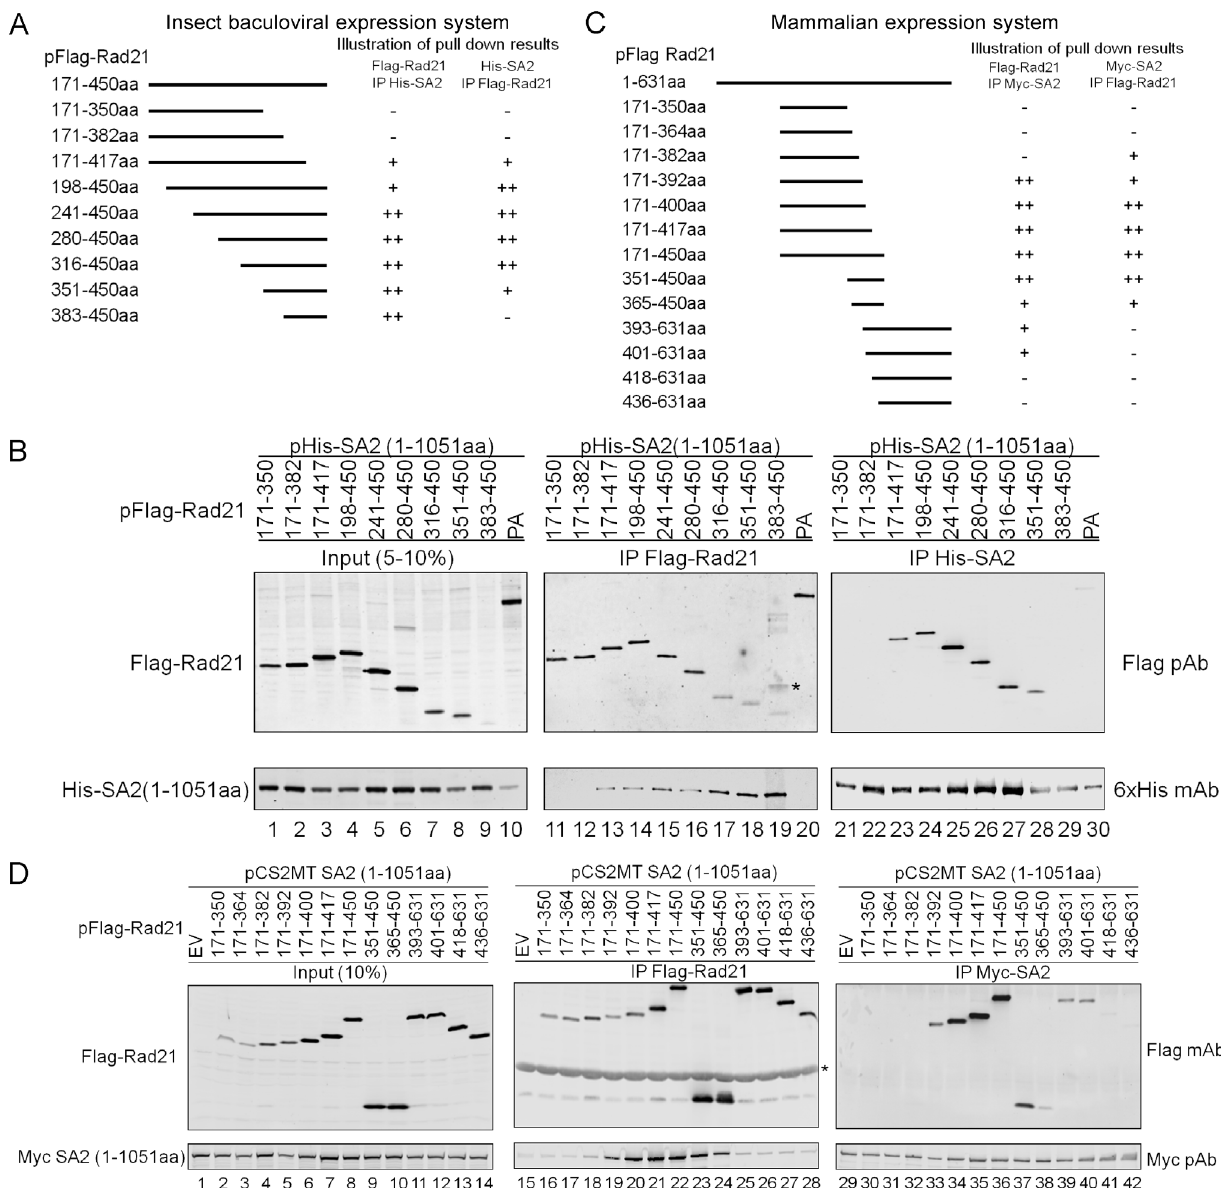
Figure 3. SA2 interacts with a 10 aa region of middle part Rad21. ( A ) Schematic illustration of the middle portion Rad21 deletion constructs made in the baculovirus system and interaction results of Rad21-SA2 from (B). ++ : strong interaction; + : weak interaction; 2 : no interaction. ( B ) Rad21 (171–382 aa) does not interact with SA2. His-SA2 (1–1051 aa) was expressed along with the Flag tagged Rad21 deletion mutants and co-purified with Ni-NTA or Flag beads. Antibody cross-reaction bands are marked by asterisk (*). ( C ) Schematic illustrations of Rad21 deletion constructs in the context of the full length Rad21 in the mammalian expression vector pFlag CMV2 and interaction results from (D). ++ : strong interaction; + : weak interaction; 2 : no interaction. ( D ) Rad21 383–392 aa region is critical for interacting with SA2. Myc-SA2 (1–1051 aa) was co-transfected along with the Flag-Rad21 deletion mutants and immunoprecipitated with Flag or Myc beads and probed with either the Myc polyclonal antibody (Myc pAb) or the FLAG mAb. Flag empty vector (EV) was used as a negative